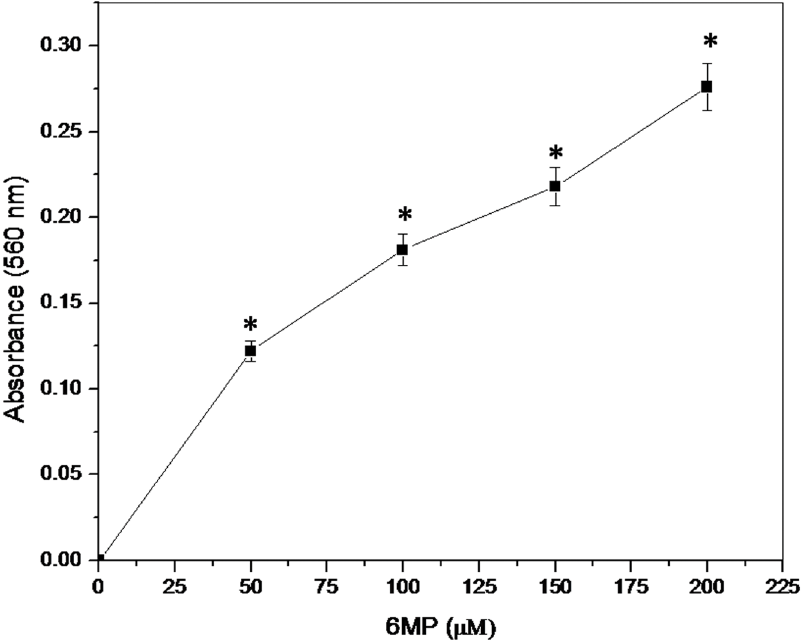
Figure 10. 6MP induced generation of superoxide anion. Concentration dependent photo generation of superoxide anion by 6MP. Indicated concentration of 6MP was exposed to white light for 1h at RT and absorbance was measured at 560 nm. Values reported are 6 SEM of three independent experiments. * p value , 0.01 when compared to control.